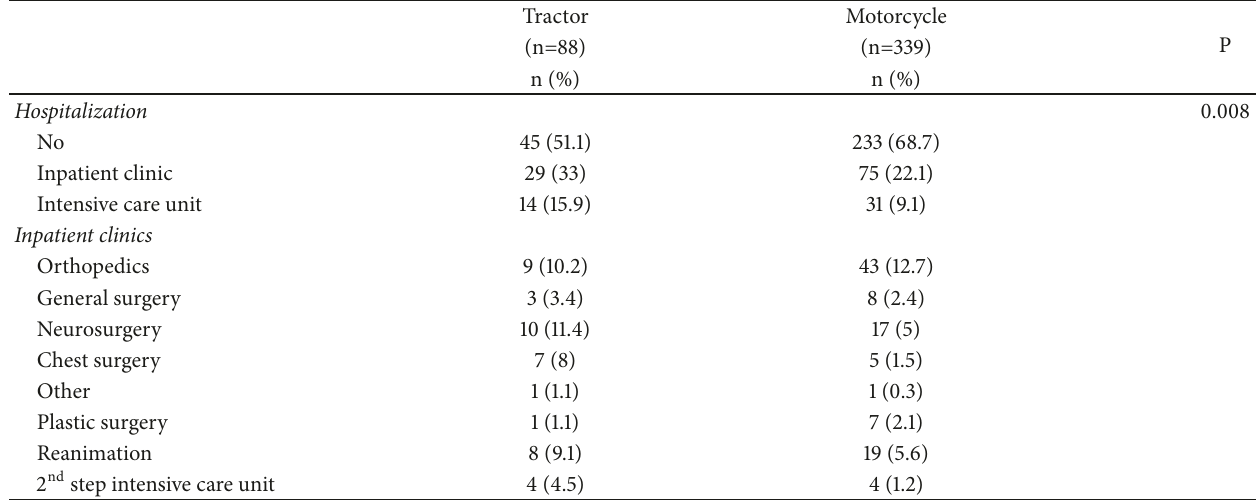
Table 4: Patient